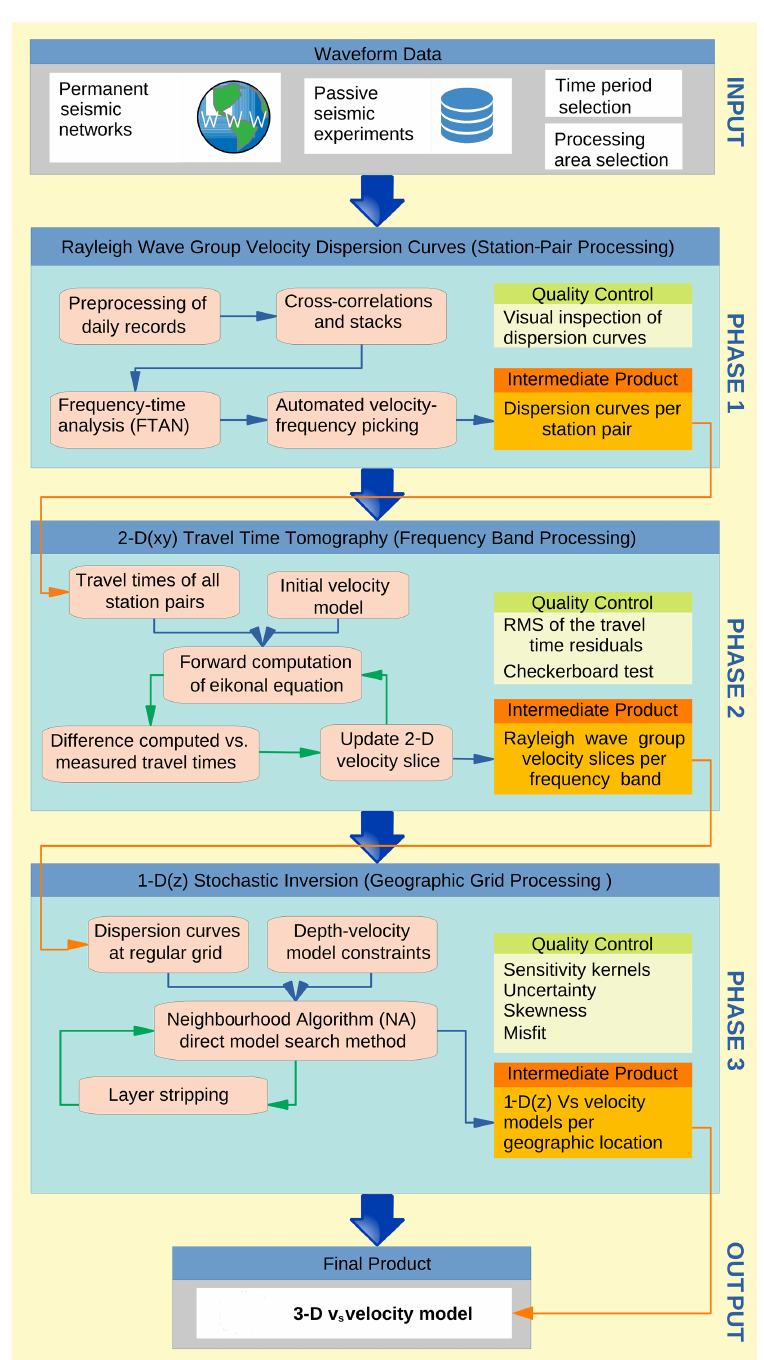
Figure 4. Flow chart of the method and data